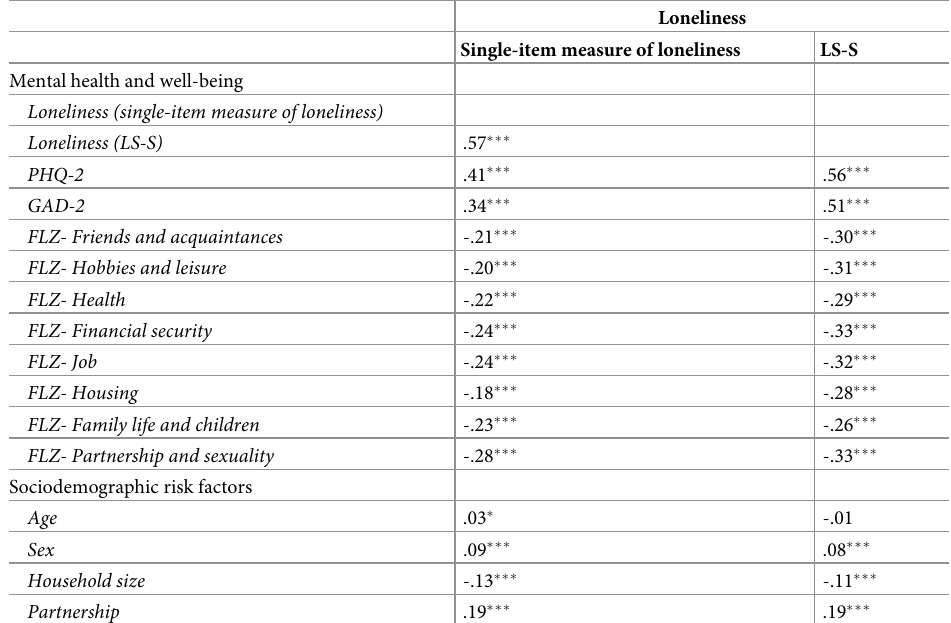
Table 4. Associations between the single-item measure of loneliness and the LS-S with other mental health out- comes and previously established sociodemographic risk factors. Loneliness Single-item measure of loneliness